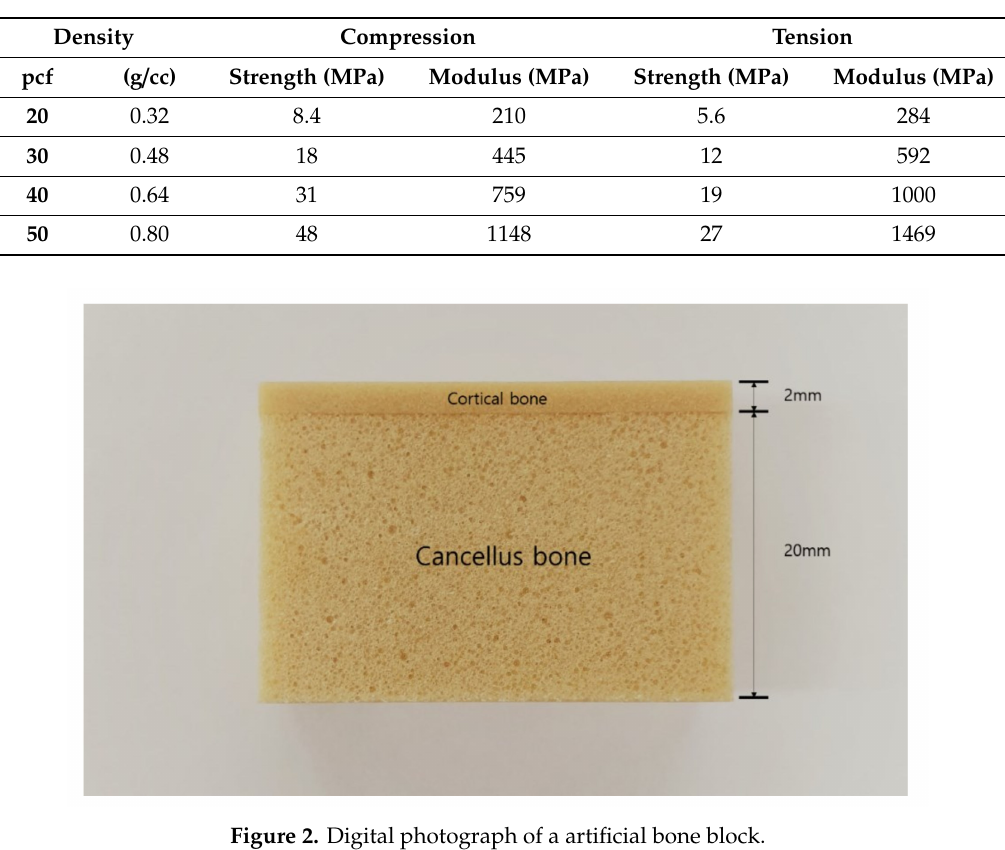
Figure 2. Digital photograph of a artificial bone